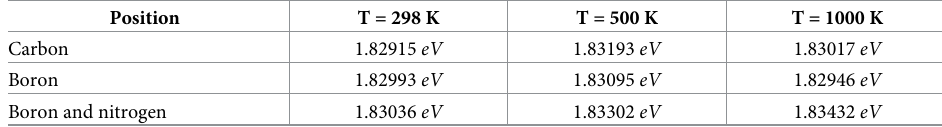
Table 1. Comparison of energy band gap on the 12-BC 2 NNR surface at three different